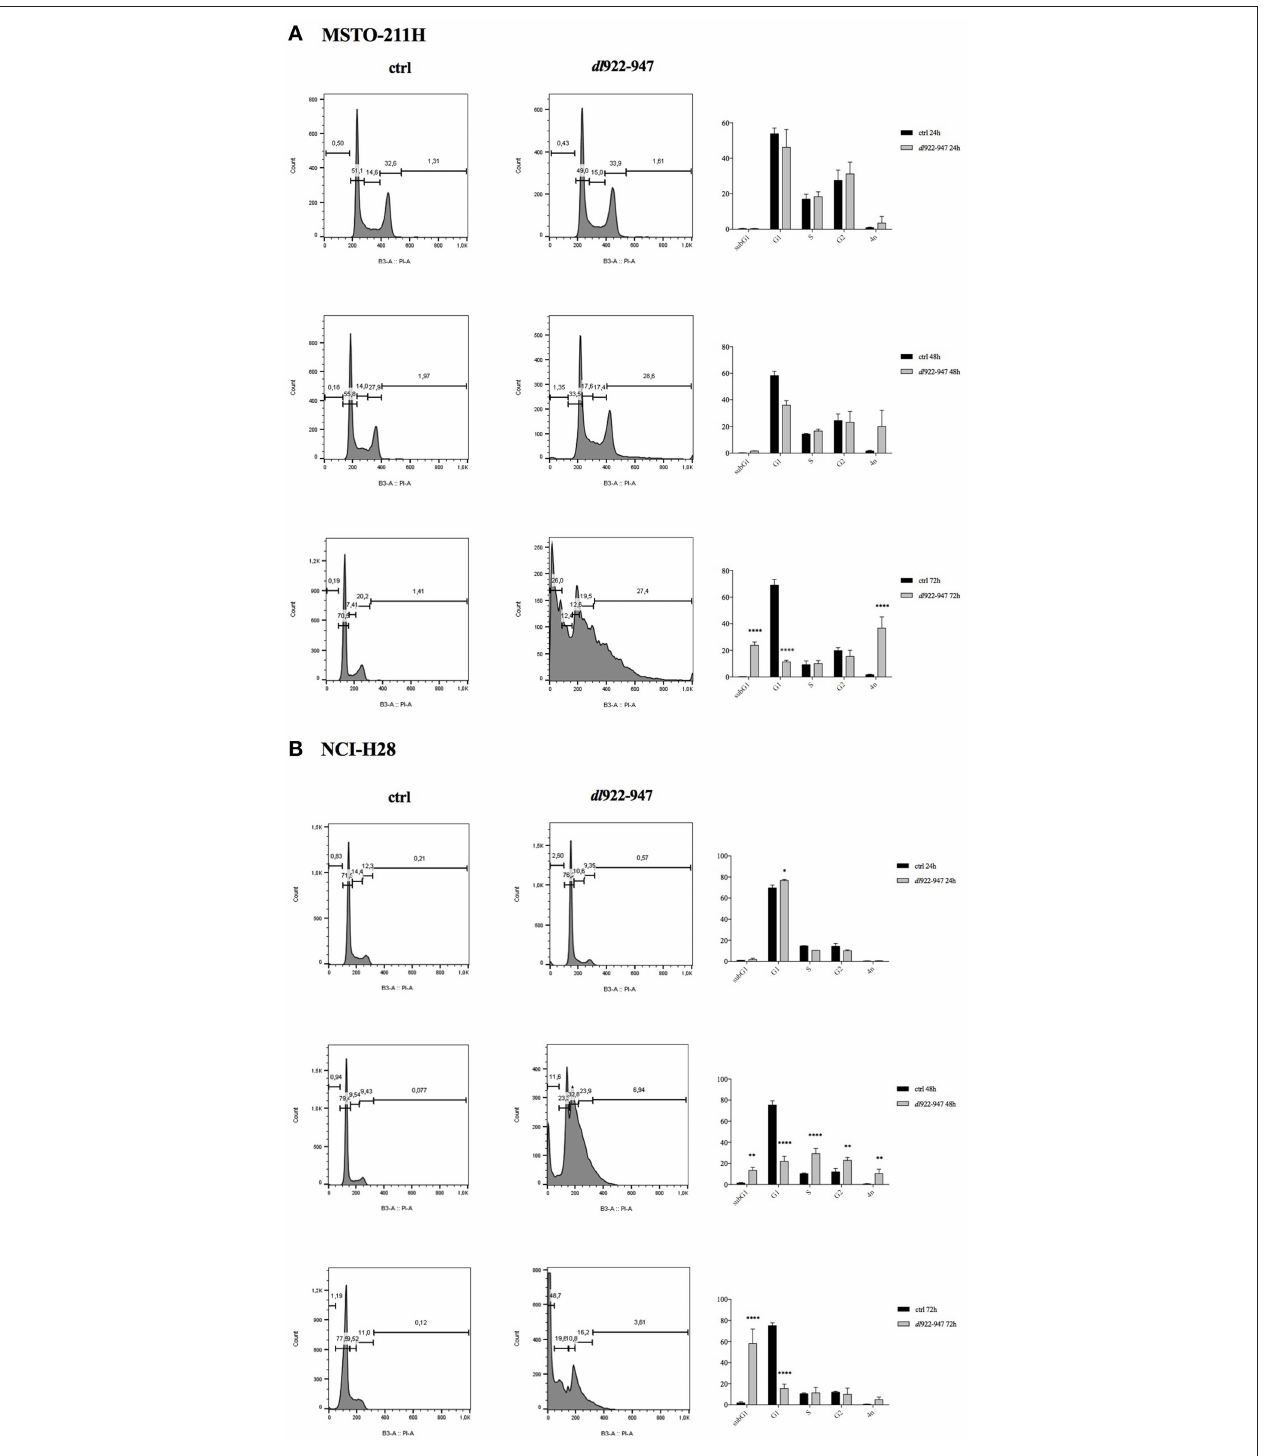
FIGURE 3 | Effect of dl 922-947 infection on cell cycle progression. MSTO-211H (A) and NCI-H28 (B) cells were infected with dl 922-947 and compared with the uninfected controls by flow cytometry 24, 48, and 72 hpi. A representative cell cycle profile is shown on the left, the histograms on the right represent the means ± s.d. of at least three independent experiments. Statistical analysis was performed by two-way ANOVA with Sidak post-hoc test (* p < 0.01, ** p < 0.005, *** p < 0.001, and **** p < 0.0001).